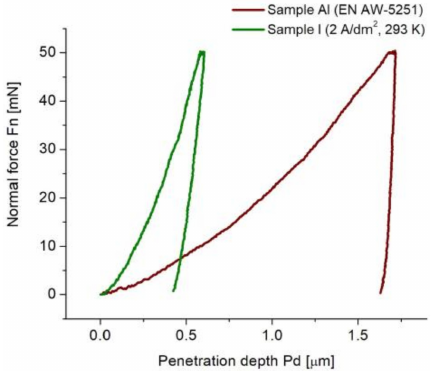
Figure 7. Load–unload curves for: aluminum alloy surface (Simple Al) and oxide layer (Sample